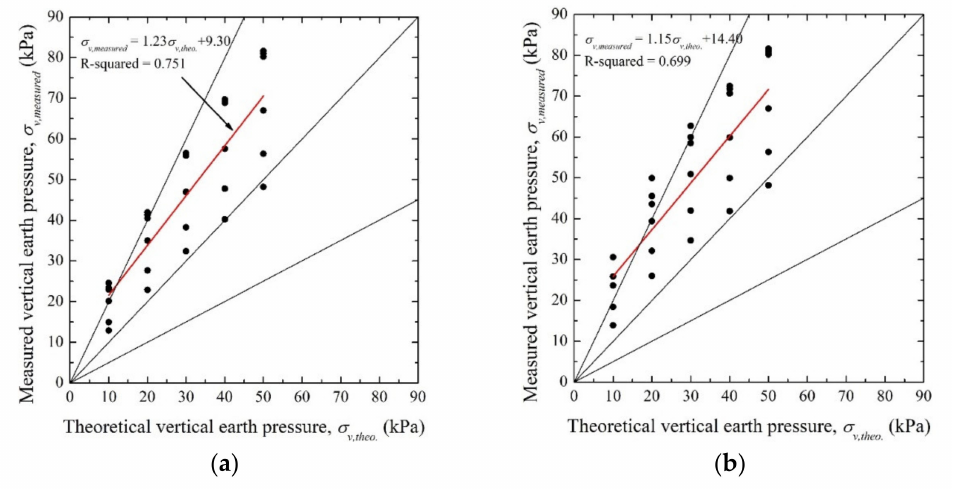
Figure 10. Theoretical vs. measured vertical earth pressure under the ( a ) loading and ( b ) unloading